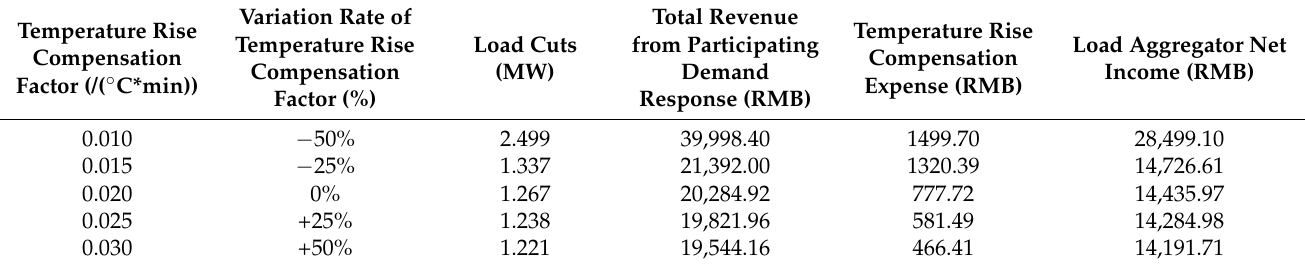
Table 4. Influence of different temperature rise compensation coefficients on demand response